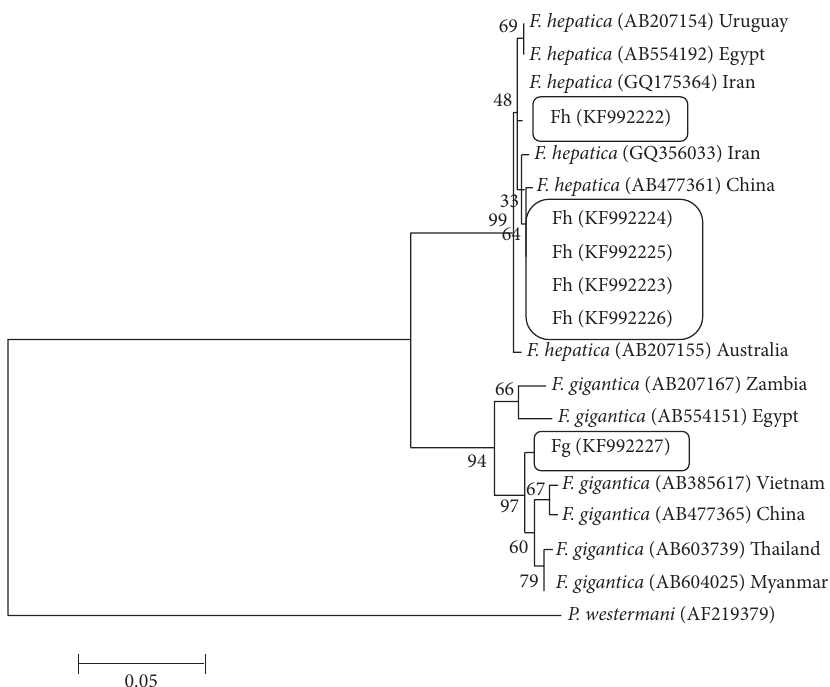
Figure 8: Phylogenetic relationship of NDI sequences of isolates of Fasciola hepatica and Fasciola gigantica from Iran using Maximum Likelihood method. Paragonimus westermani (AN: AF219379) was used as the out